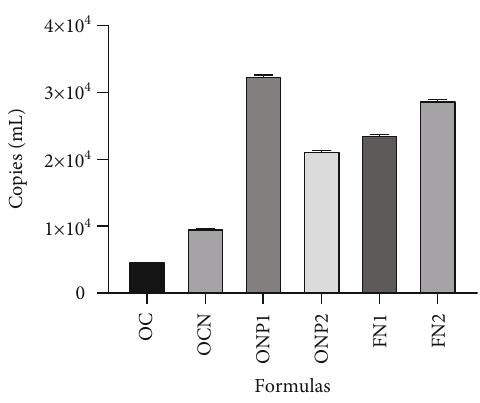
Figure 4: Real time-PCR results for rhl gene of the six stimulated formulas.